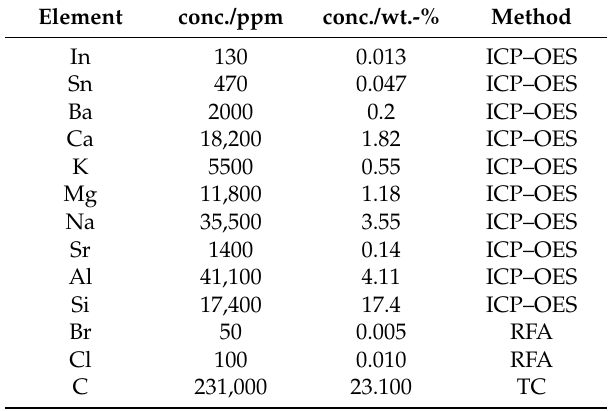
Table 1. Chemical analysis of milled smartphone displays.